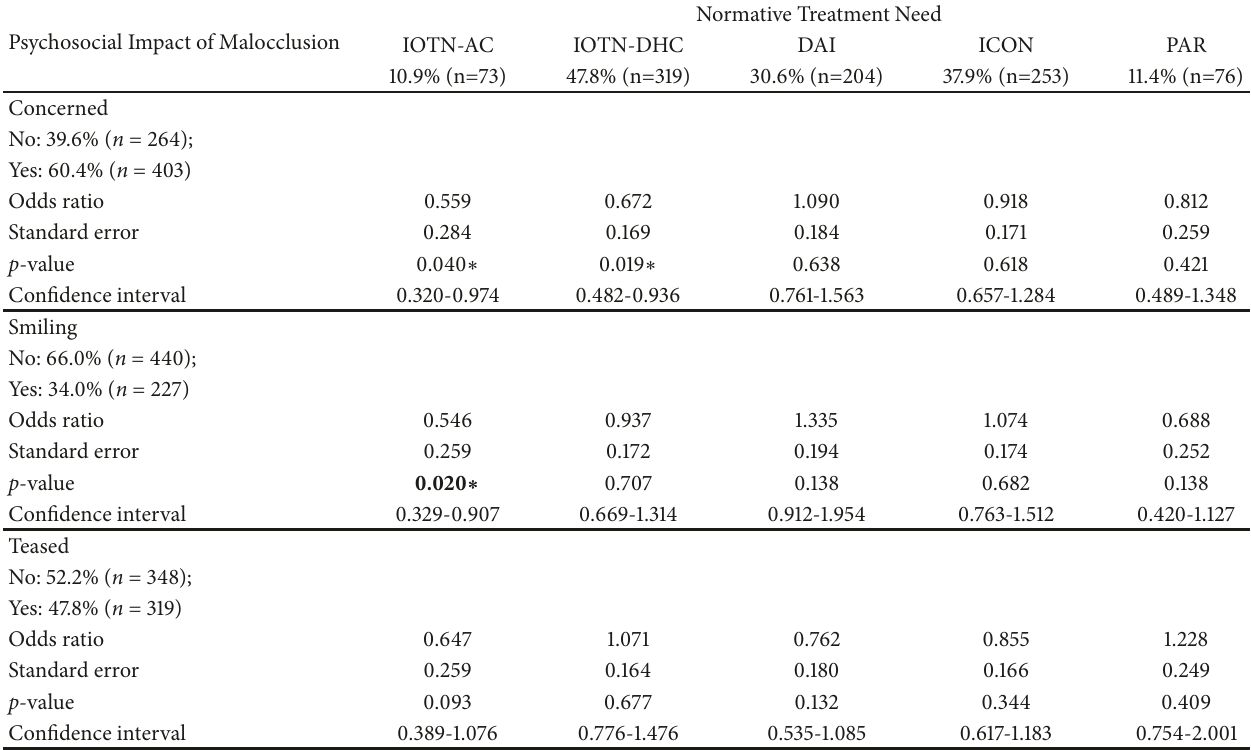
Table 3: Associations between normative treatment need and the psychosocial impact of malocclusion. Psychosocial Impact of